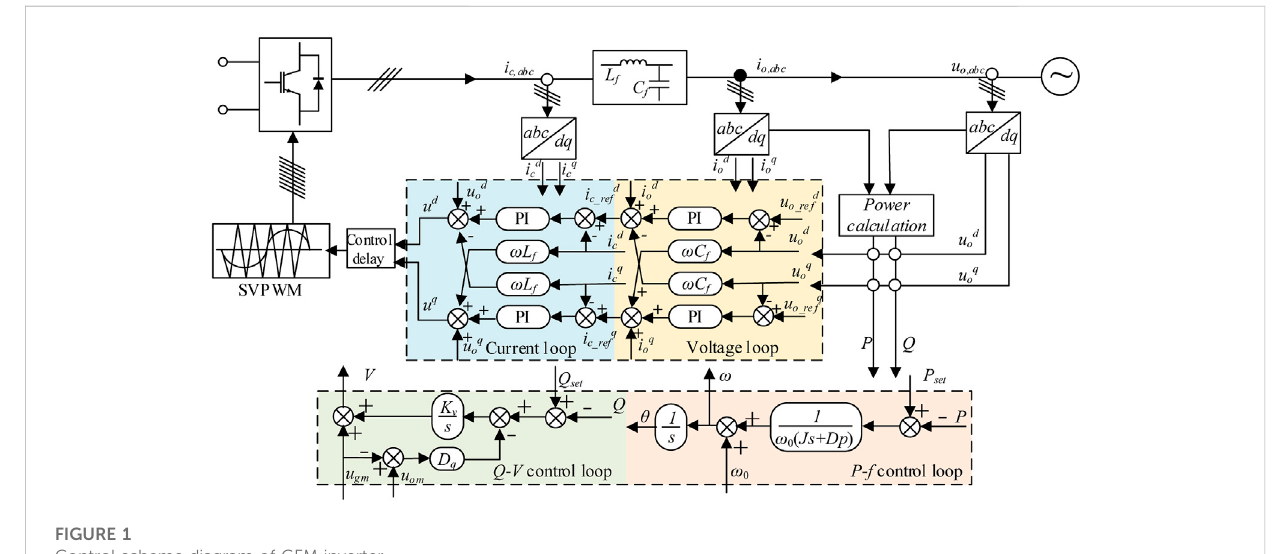
FIGURE 1 Control scheme diagram of GFM